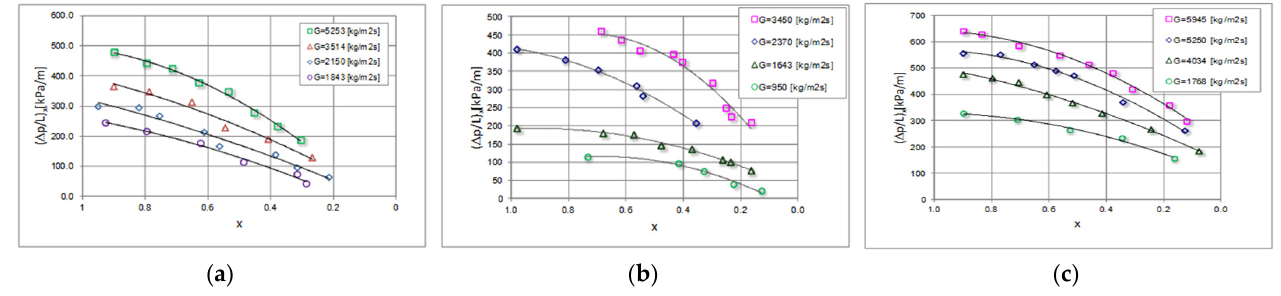
Figure 6. Experimental, local characteristics of pressure drops ( Δ p/L) x depending on the vapour quality x during the condensation in a mini-channel with a hydraulic diameter d h = 0.8 mm, refrigerants: